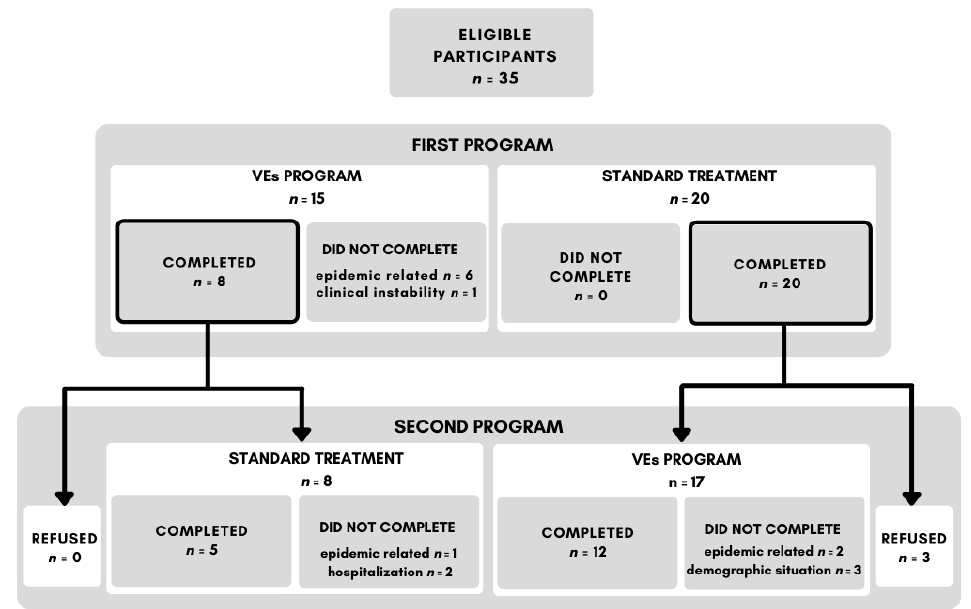
Figure 2. Adherence to the treatment and study procedure flow chart.